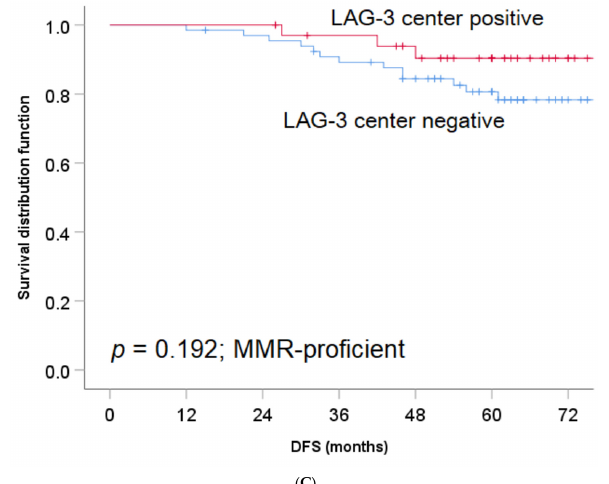
Figure 3. ( A ): The impact of LAG-3 expression on TILs on DFS in patients with stage II MMR-proficient colon cancer (tumor center and tumor front). ( B ): LAG-3 expression on TILs at tumor front and its effect on DFS in stage II MMR-proficient colon cancer. ( C ): LAG-3 expression on TILs in the tumor center and its impact on DFS in stage II MMR-proficient colon cancer.